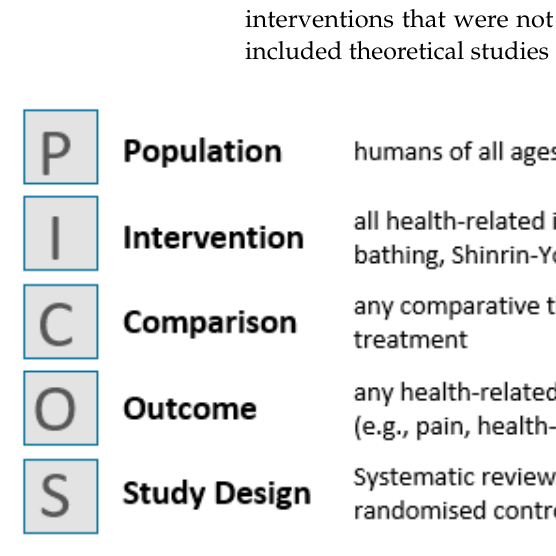
Figure 1. Inclusion and exclusion criteria based on PICOS (Population, Intervention, Comparator, Outcome, Study design) [24].